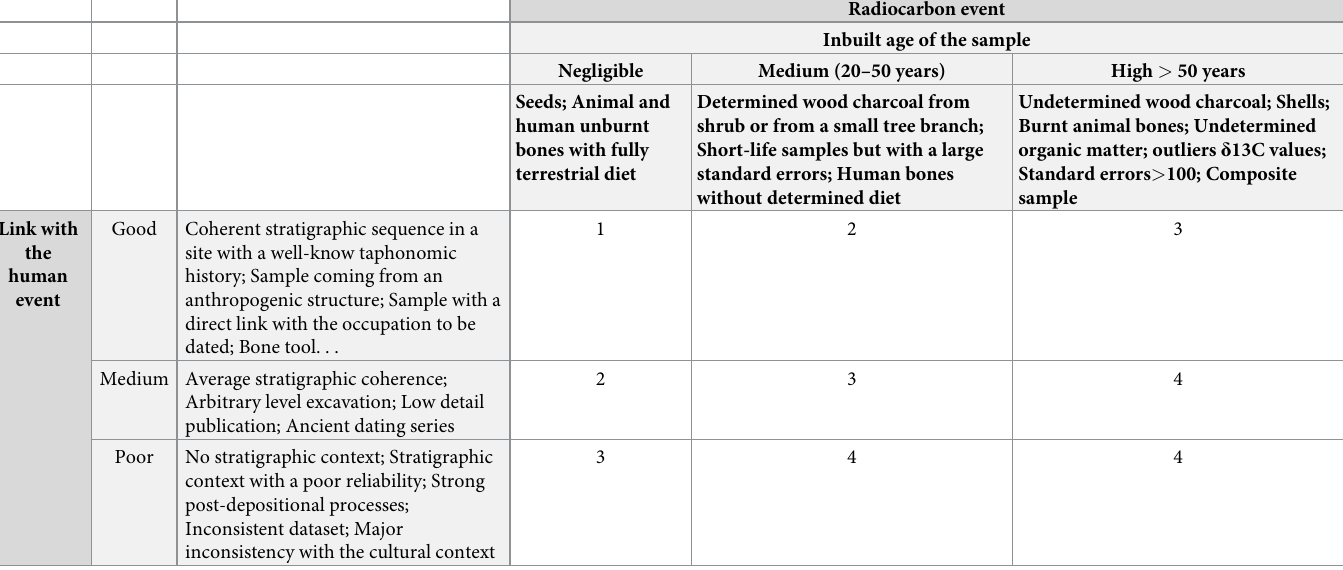
Table 1. Criteria for the reliability evaluation of radiocarbon